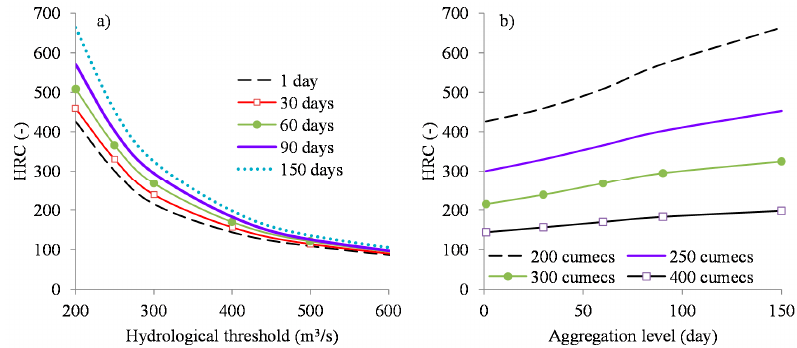
Figure A12. Hydrological response constant (HRC) versus: ( a ) hydrological deficit; and ( b ) duration.